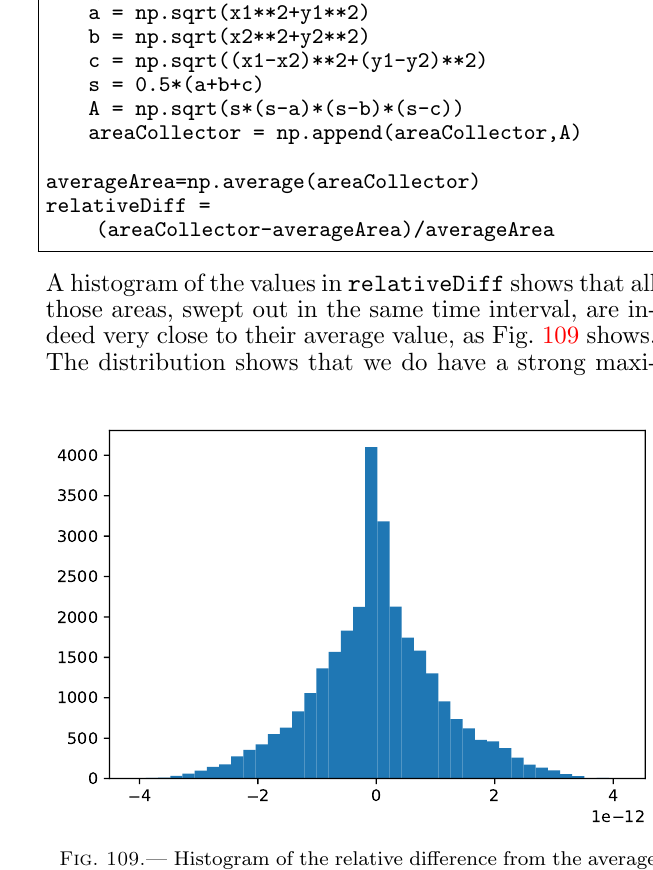
mum at the average area value, with small (a few parts in a trillion!) fluctuations to smaller and larger